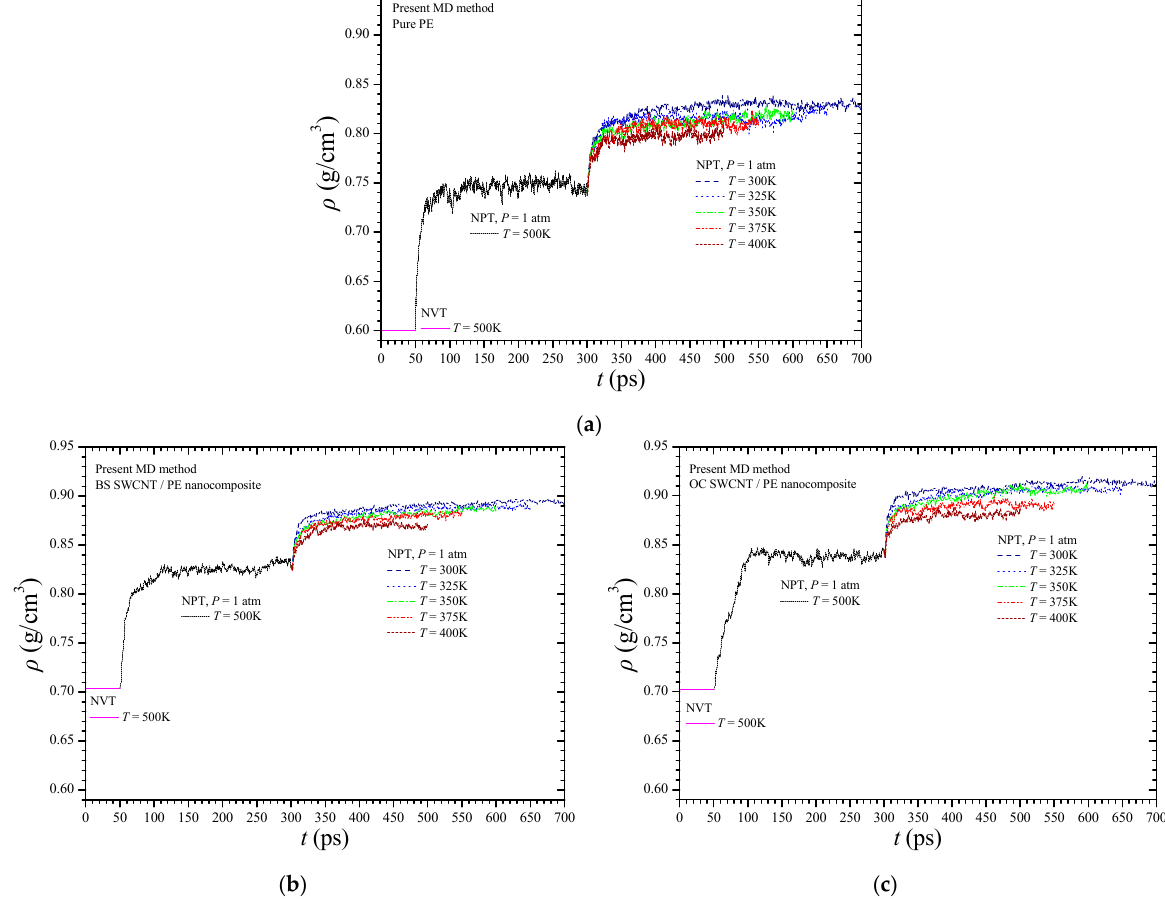
Figure 5. The density of the simulated ( a ) pure PE, ( b ) BS SWCNT-reinforced PE, and ( c ) OC SWCNT-reinforced PE versus time during the dynamic analysis and at various temperatures.